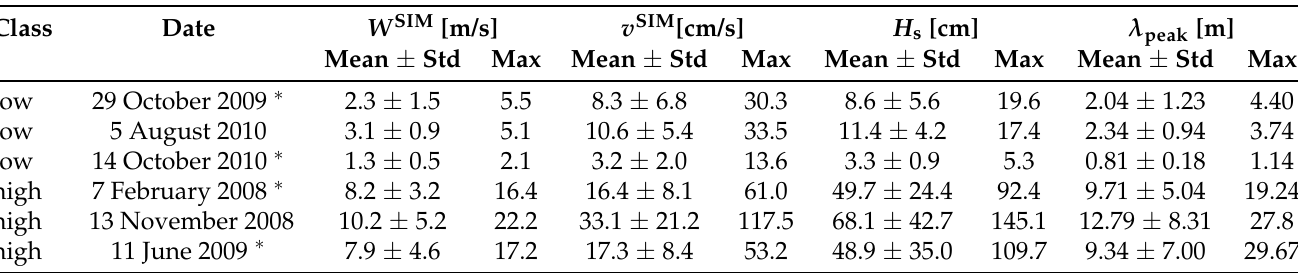
Table 1. Mean, standard deviation and maximum of the simulated key geophysical quantities for each date considered. Module of wind speed from WRF ( W SIM ); module of the surface water velocity from Delft3D + SWAN ( v SIM ); significant wave height ( H s ) and peak wavelength ( λ peak ) from